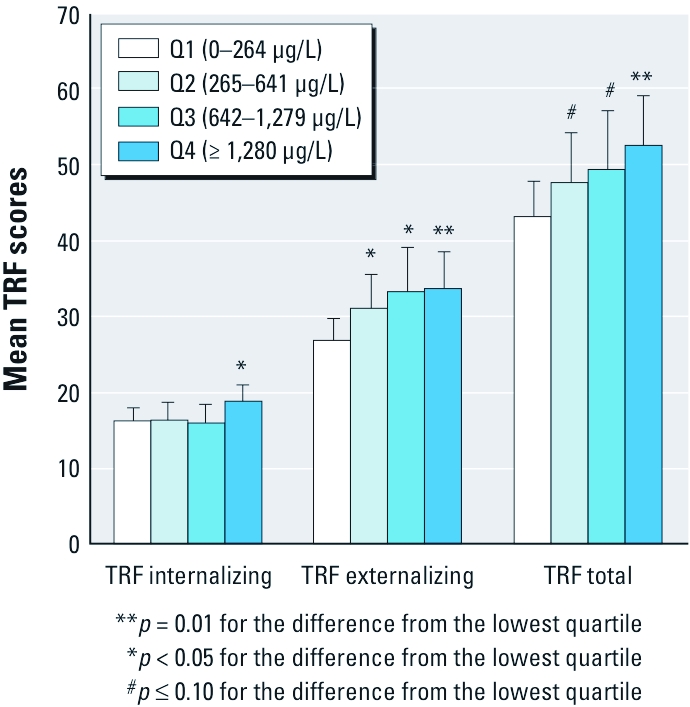
Adjusted mean negative classroom behavior scores by quartiles (Q) of WMn for TRF internalizing, TRF externalizing, and TRF total behaviors. Adjustments were made for sex, maternal education, arm circumference, and BMI and controlling for within-teacher correlations in rating the children. Error bars indicate 95% CI for the quartile-specific estimate.